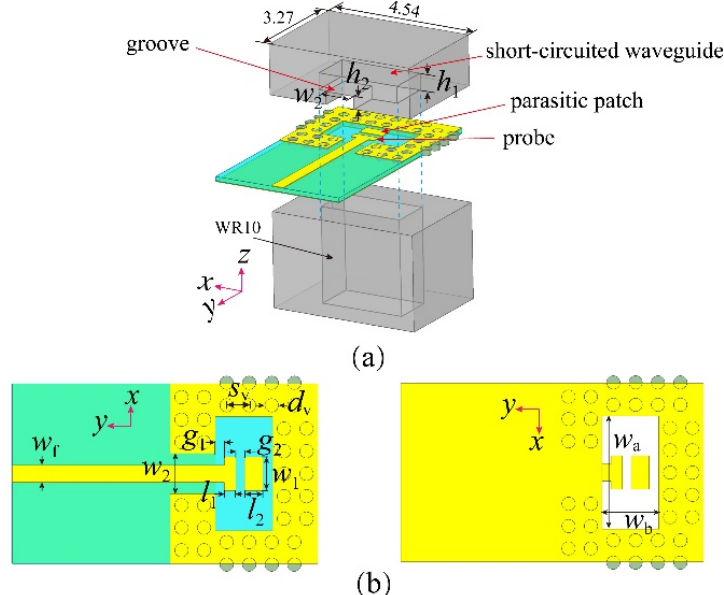
Figure 3. The configuration of the proposed transition. ( a ) 3D view. ( b ) Top view.